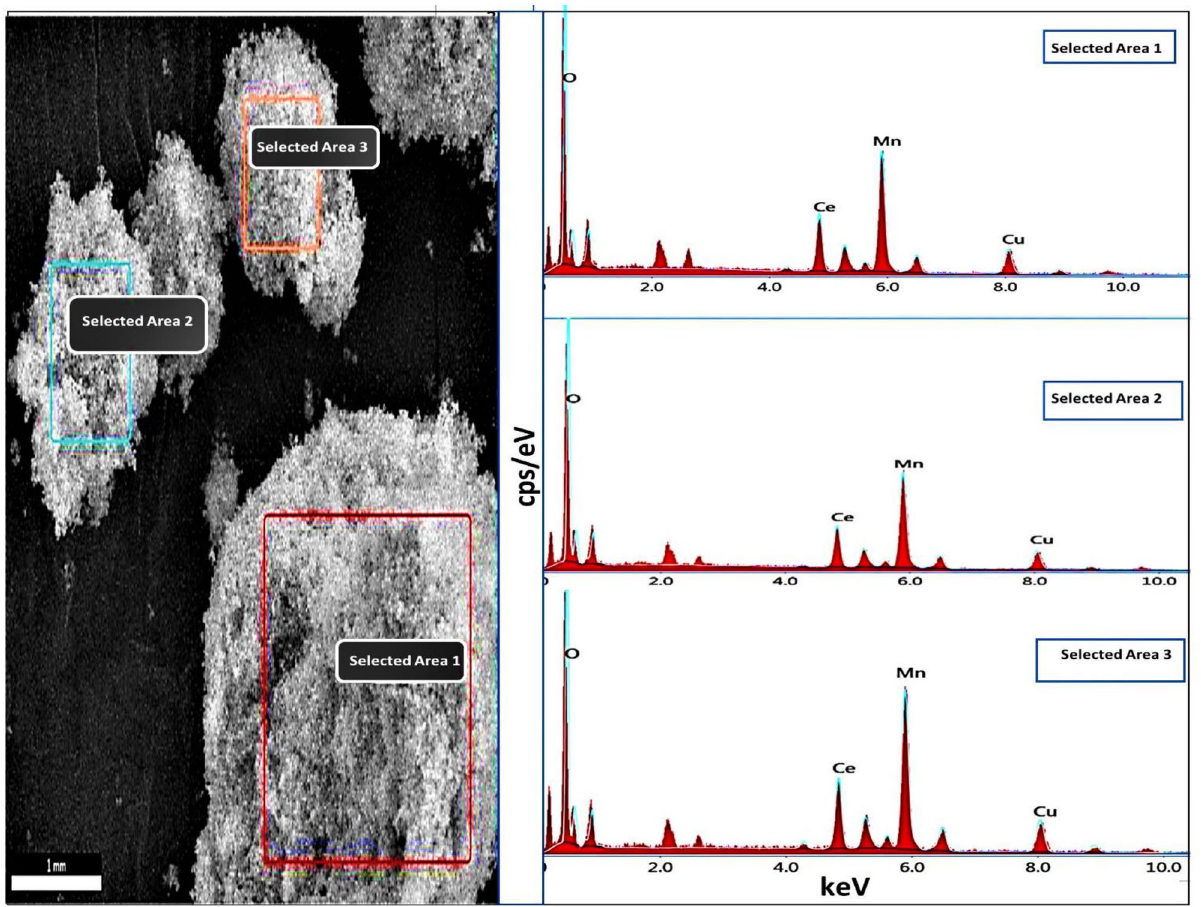
Figure 5. EDAX spectrum of three selected area of CMCu.